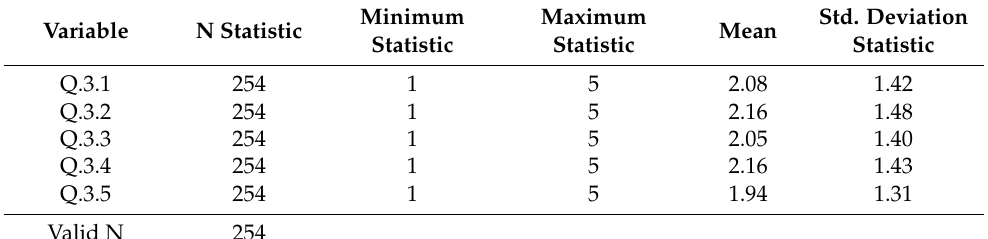
Table 10. Descriptive statistics of sources of financing for setting up a company.